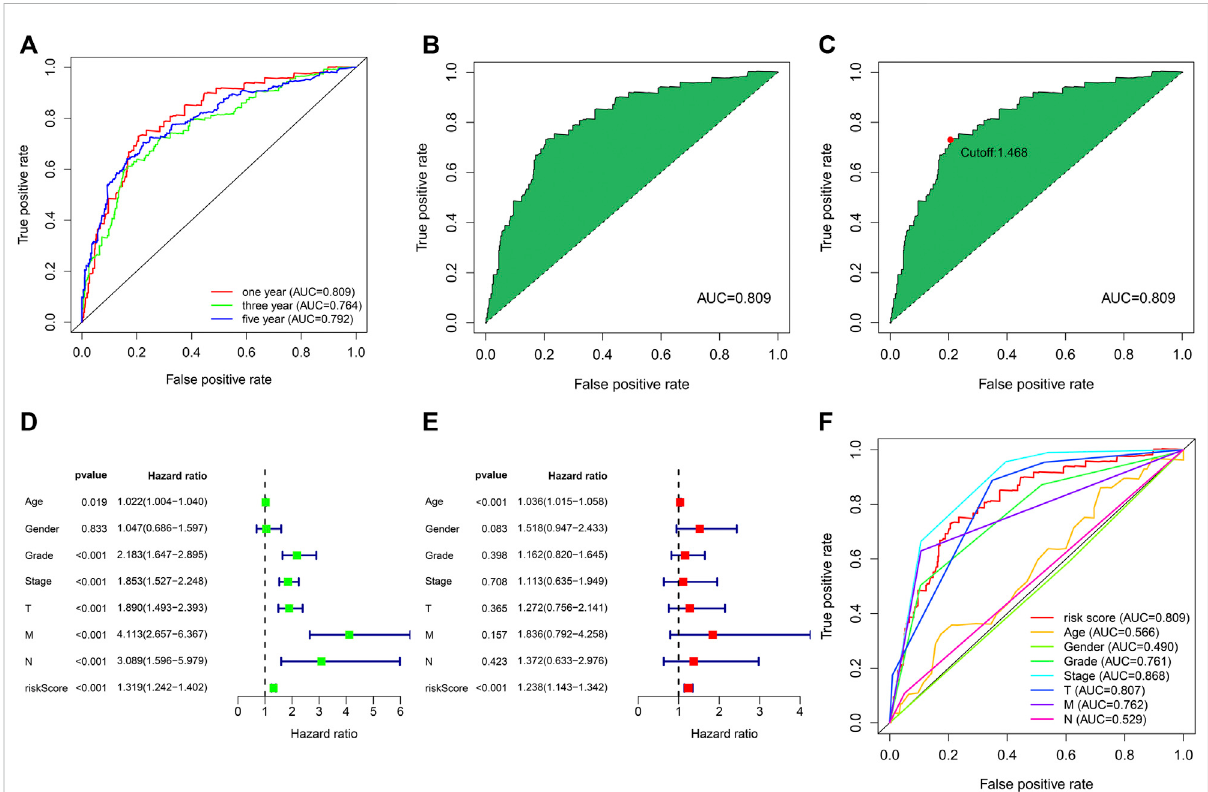
FIGURE 3 Theassessionoftheprognosispredictionability ofrisk models. (A) The1-,3-and5-yearROCcurves. (B) One-yearROC curvewithmaximal AUC result acquired based on the modeling method. (C) The cutoff value of 1.468 distinguishing risk high and risk low sufferers was acquired through the best fi t. (D) Univariable cox regressive analysis of the associations of clinical-related indicators and risk score with the prognoses of ccRCC. (E) Multivariablecoxregressiveanalysisoftheassociationsofclinical-relatedindicatorsandriskscorewiththeprognosesofccRCC. (F) Comparison of the AUC values of clinical indicators and risk